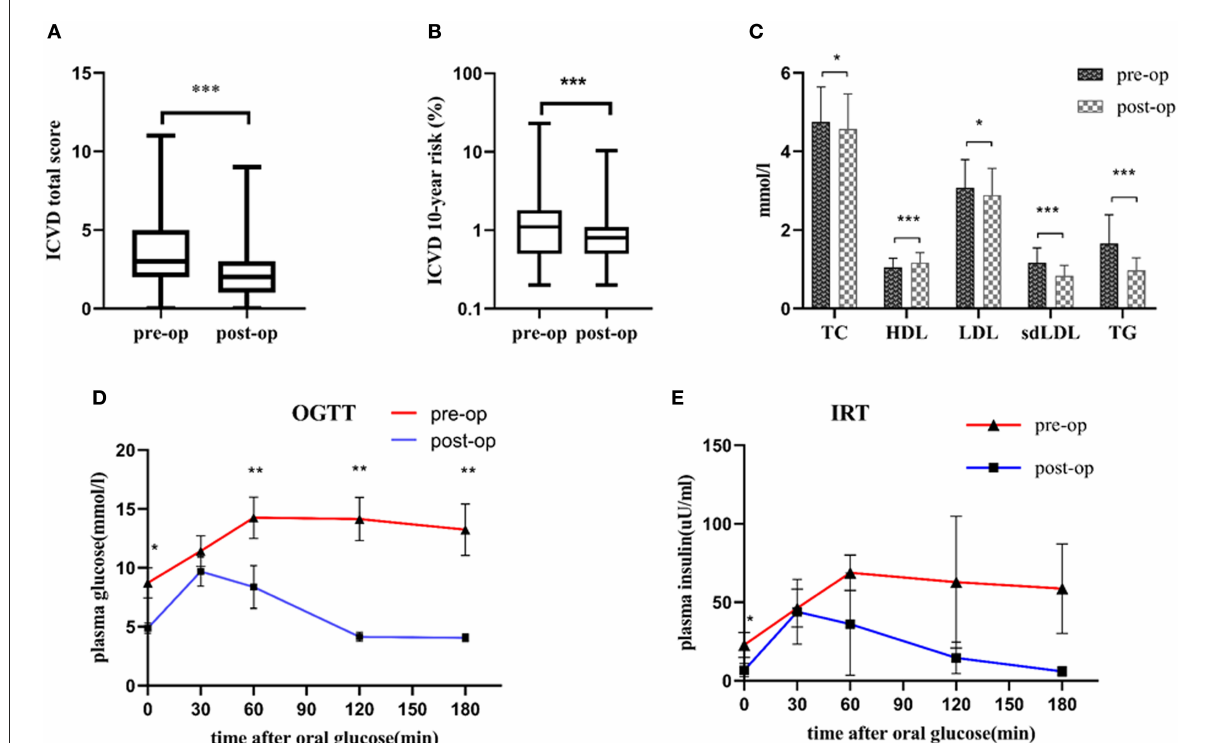
FIGURE2 (A) Decreases in ICVD total score 6 months post-operation compared with pre-operation; (B) Decreases in ICVD 10-year risk 6 months post-operation compared with pre-operation; (C) Improvements in TG, TC, LDL, sd-LDL and HDL 6 months post-operation compared with pre-operation. (D) Decreases in the OGTT 6 months post-operation compared with pre-operation. (E) Decreases in IRT 6 months post-operation compared with pre-operation. * p < 0.05, ** p < 0.01, *** p < 0.001 post-operation vs. pre-operation ICVD, ischemic cardiovascular disease; TG, triglyceride; TC, total cholesterol; LDL, low-density lipoprotein; sd-LDL, small dense-low-density lipoprotein; HDL, high-density lipoprotein; OGTT, oral glucose tolerance test; IRT, insulin release test. N = 107, continuous variables were expressed as the means ± standard deviations or medians and interquartile ranges. The differences in ICVD total score and ICVD 10-year risk between pre-operative group and post-operative group were evaluated by Wilcoxon’s signed rank test. The paired-sample t -test was used to compare pre- and post-operative levels of TC, HDL, LDL, sdLDL, TG, OGTT and